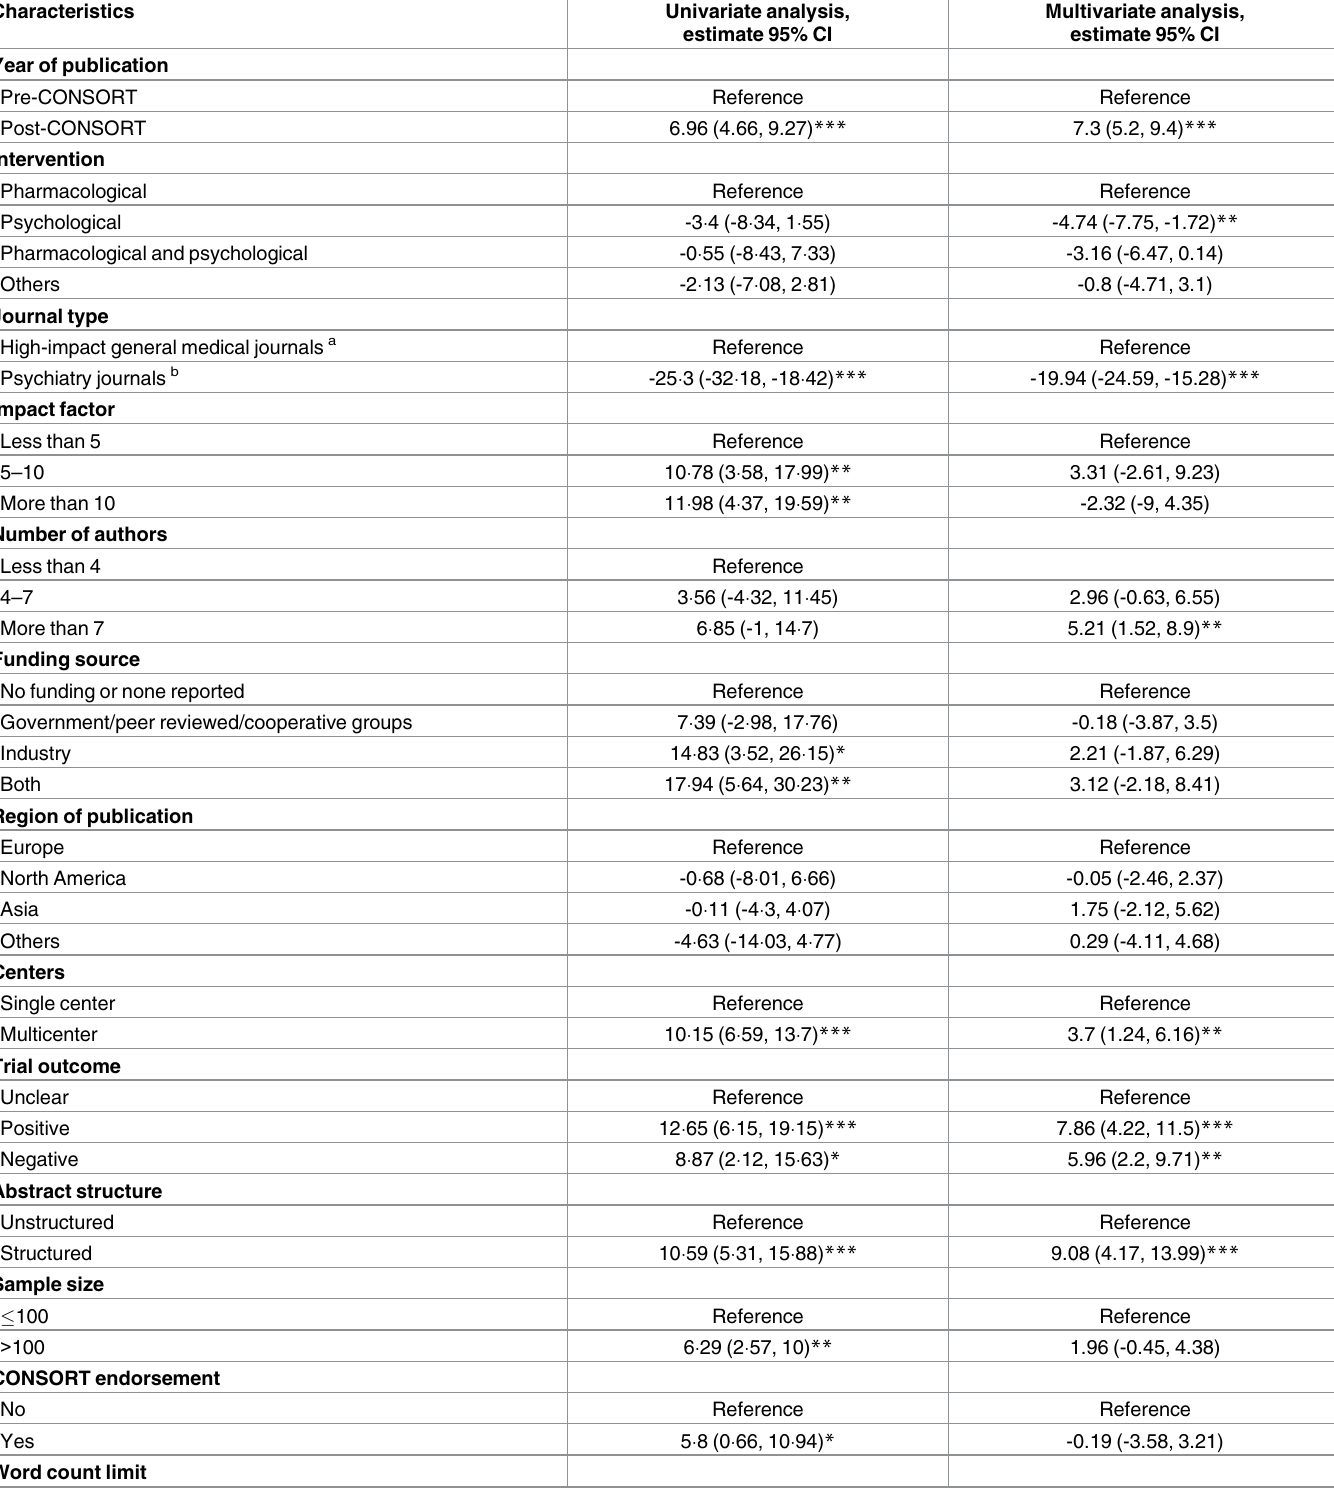
Table 3. Linear regression derived estimatesand 95% CI with mean overall quality scoreon a modified percentagescale as the dependent variable for psychiatry RCT